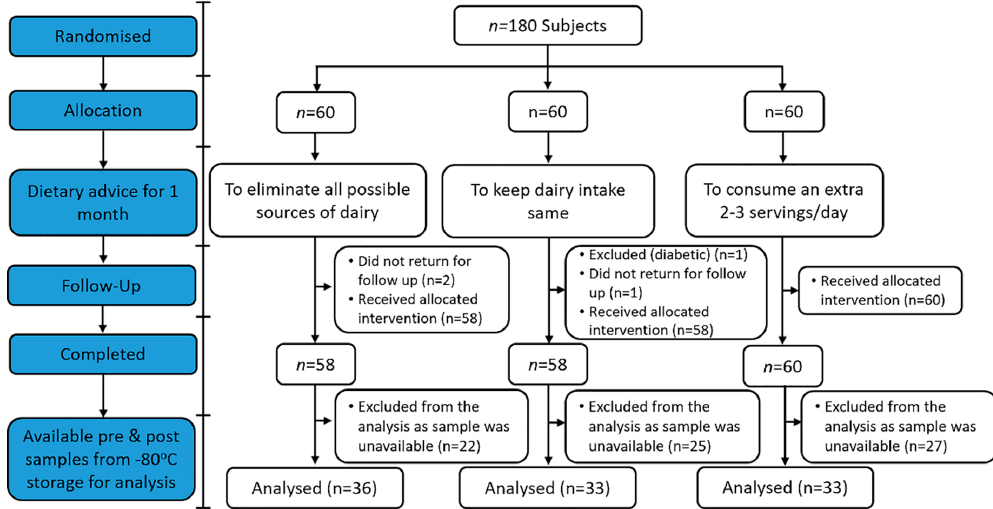
Figure 1. Flow diagram of the study participants from eligibility criteria screening to study completion.